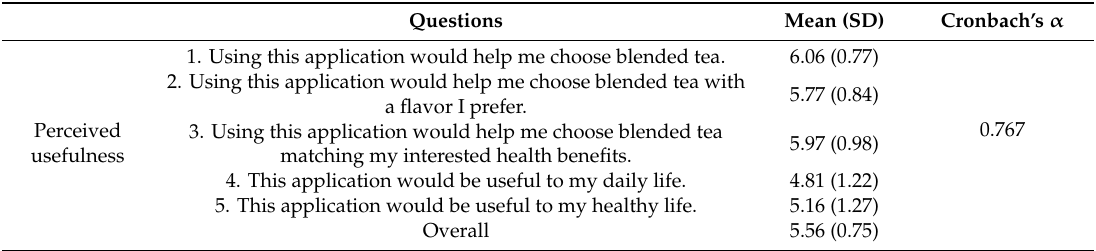
Table 3. Perceived usefulness of TeaPick TM .